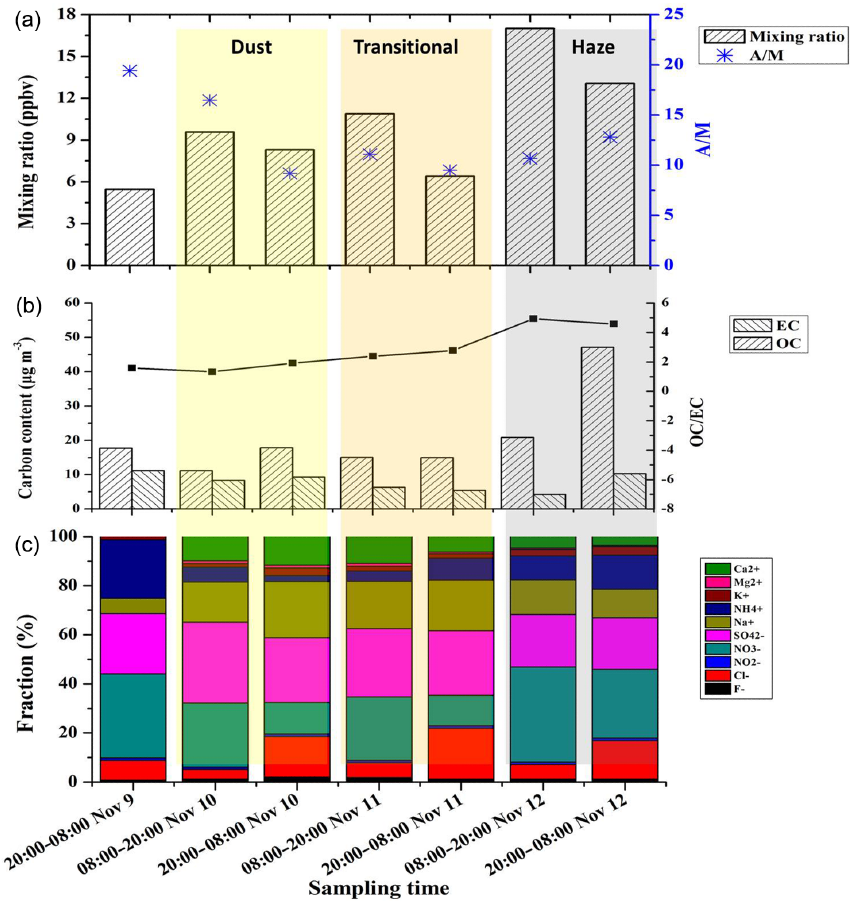
Figure 6. Variations in (a) the mixing ratios of 17 carbonyl compounds and acetone to methylglyoxal (A / M) ratios in the gas phase, (b) particulate carbon fractions, and (c) particulate water-soluble ions during the study